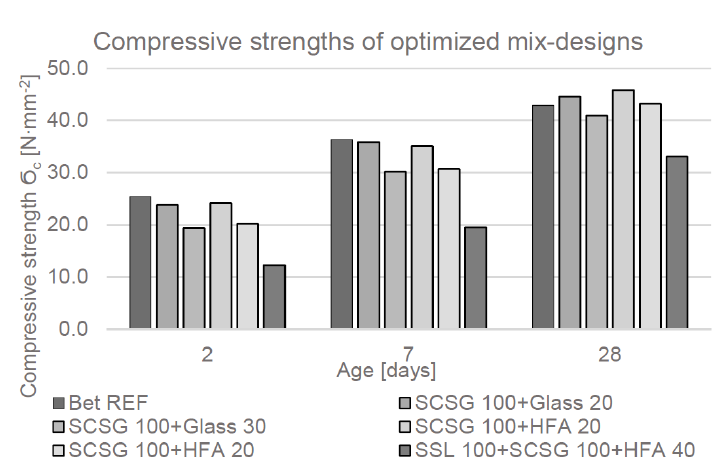
Figure 2. Compressive strengths of optimized mix-designs.